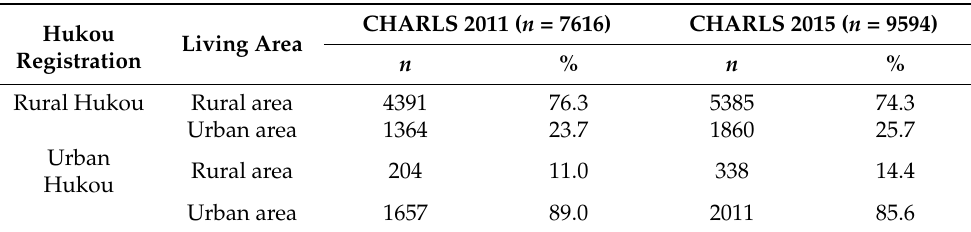
Table 1. Distribution (%) of respondents with different Hukou registration in rural and urban areas, CHARLS 2011 and CHARLS 2015.